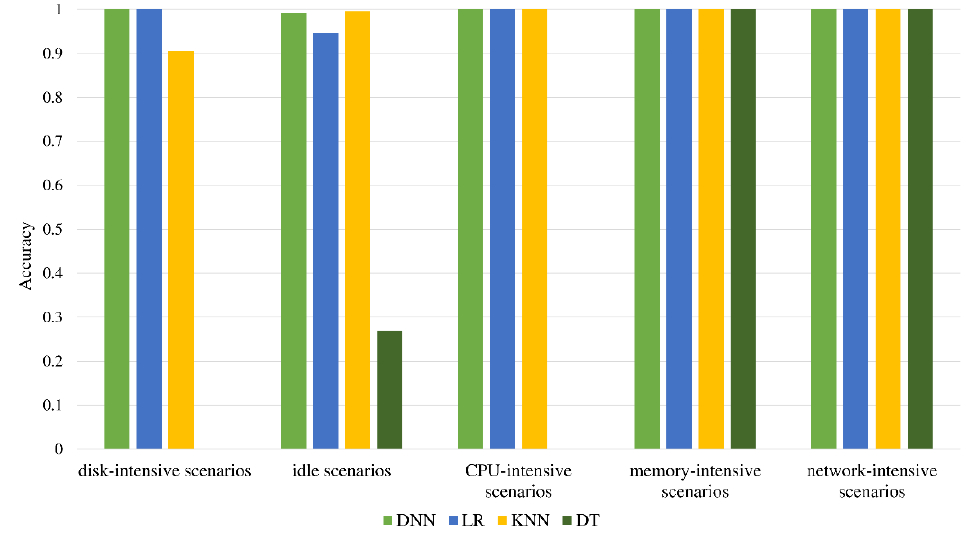
Figure 6. Comparison of classification accuracy.